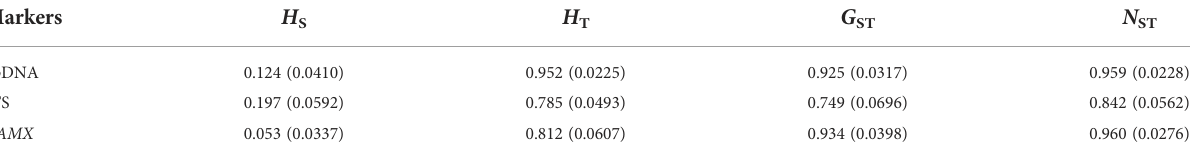
TABLE 1 Genetic diversity, differentiation indices for the combined cpDNA and nDNA in this study. Markers